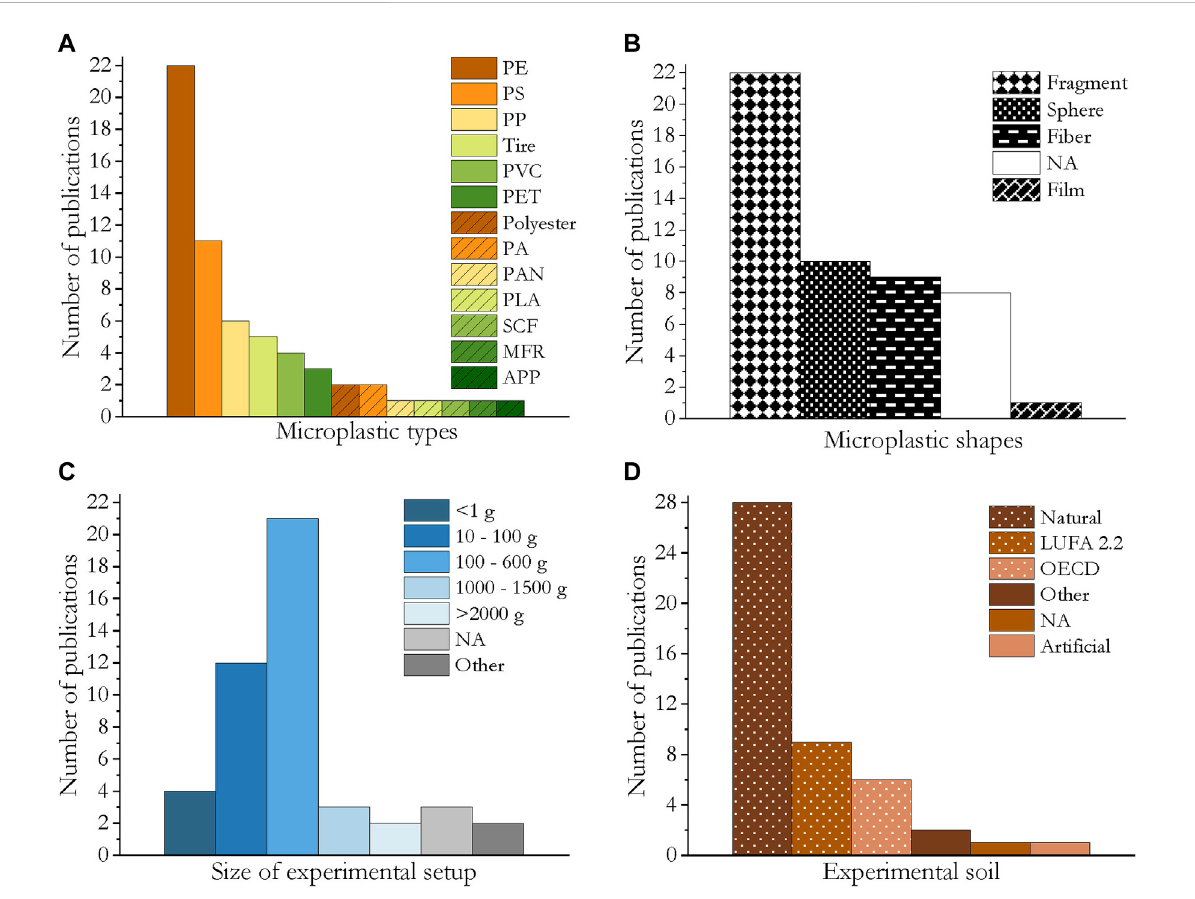
FIGURE 4 Bar charts of the experimental design and the characteristics of the applied microplastics in the reviewed publications. (A) Applied microplastic types. (B) Microplastic shapes (NA = microplastic shape not stated); abbreviations: SCF = synthetic clothing fi ber, MFR = melamine-formaldehyde resin. (C) Size of experimental setup (NA = not stated.) (D) Experimental soil (NA = soil type not